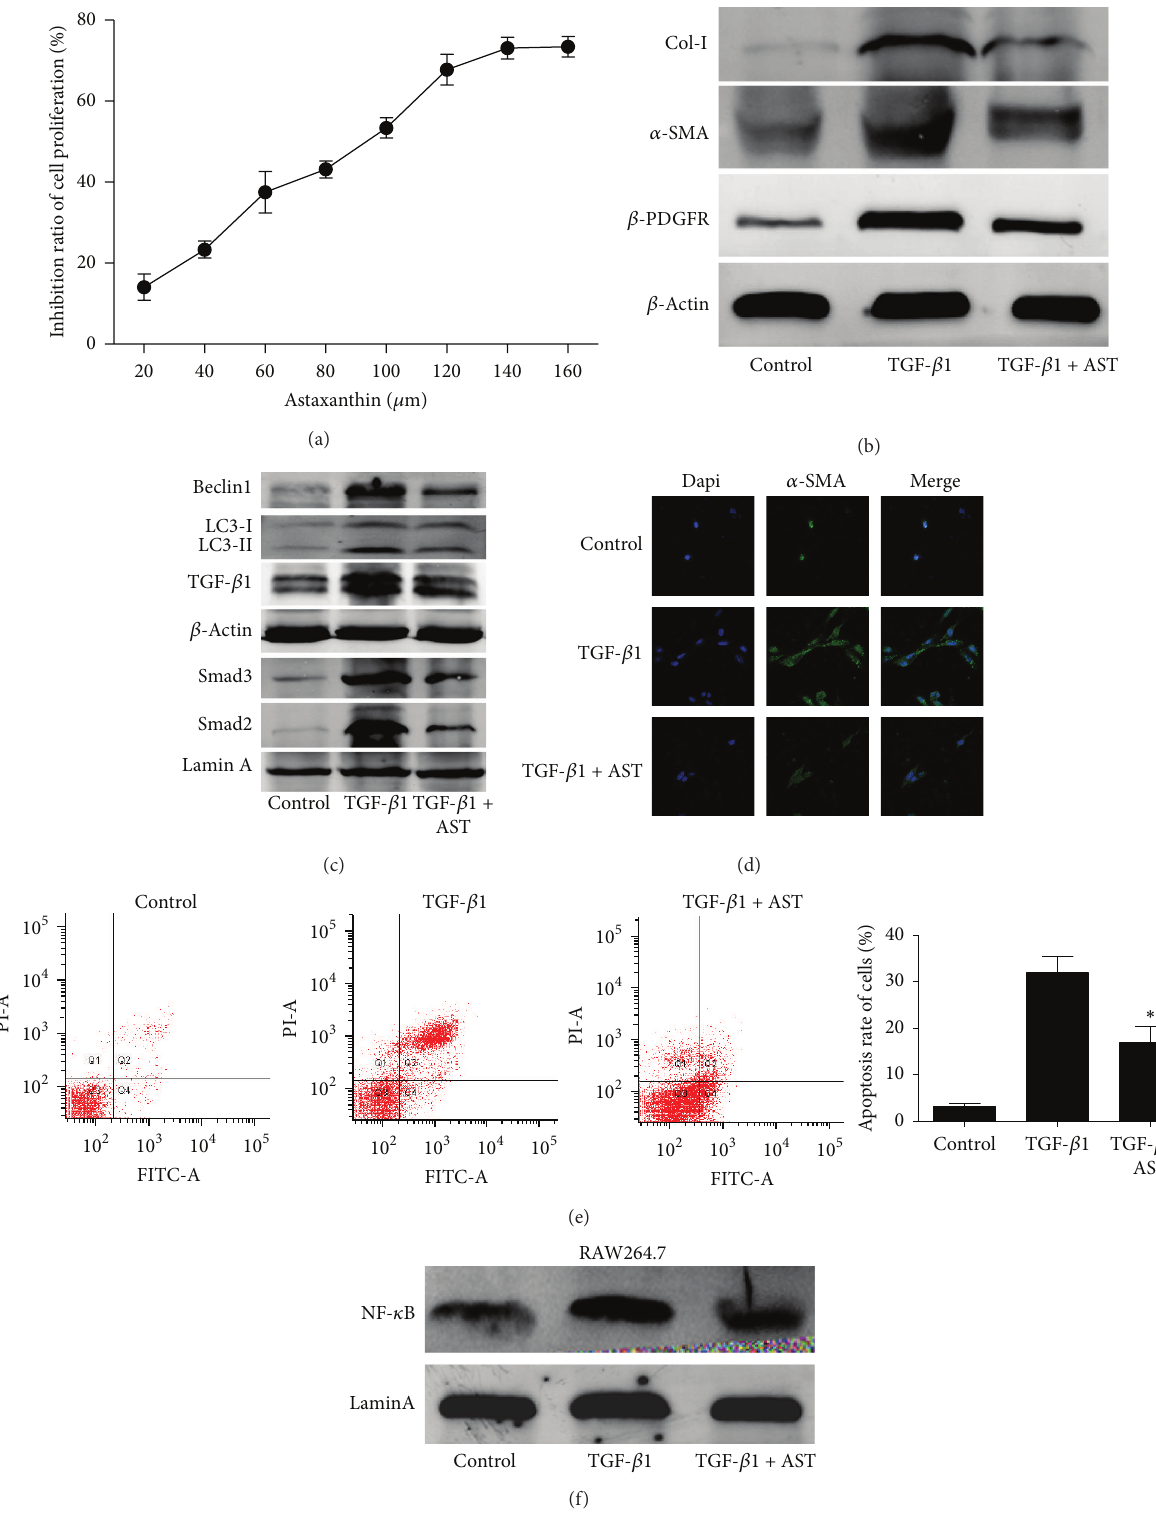
Figure 7: Effect of astaxanthin on HSC-T6, NCTC1469, and RAW264.7 cells. (a) The proliferation of HSC-T6 was detected by MTT. (b) The levels of 𝛼 -SMA, 𝛽 -pdfgr, and collagen I were detected by western blot. (c) The levels of beclin-1, LC3, TGF- 𝛽 1, Smad2, and Smad3 were detected by western blot. (d) The expression of 𝛼 -SMA in HSC-T6 cells was detected by immunofluorescence. (e) The apoptosis of NCTC1469 cells was detected by flow cytometry ( 𝑛 = 3 , ∗ 𝑃 < 0.05 for TGF- 𝛽 1 + AST(40) versus TGF- 𝛽 1). (f) The result of western blot showed that astaxanthin decreased the expression of NF- 𝜅 B in RAW264.7